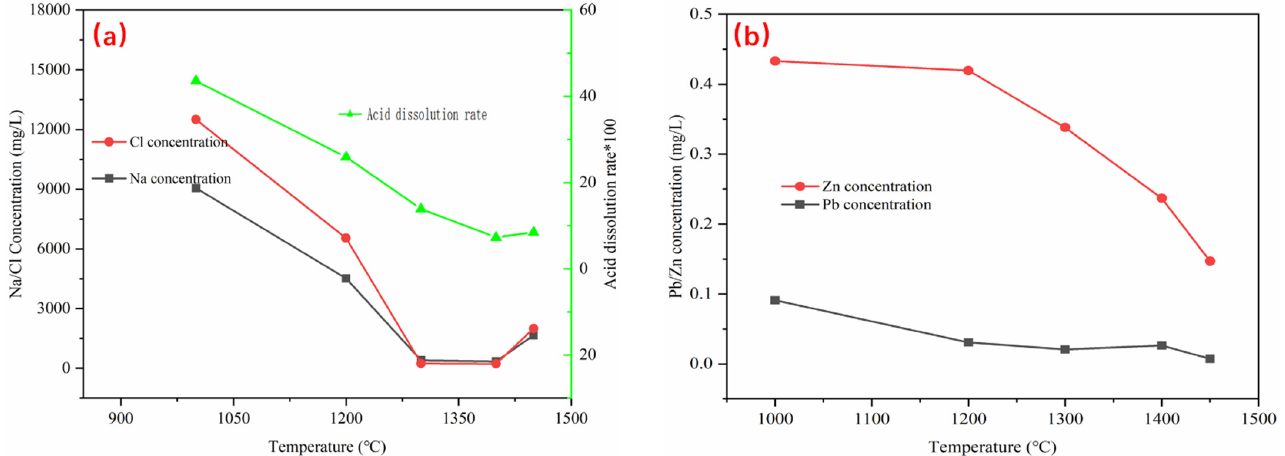
Figure 8. Test results of acid dissolution and water leaching of slag at different temperatures: ( a ) acid dissolution ratio and Cl and Na contents in water leaching solution; ( b ) Pb and Zn content in the water leaching solution.